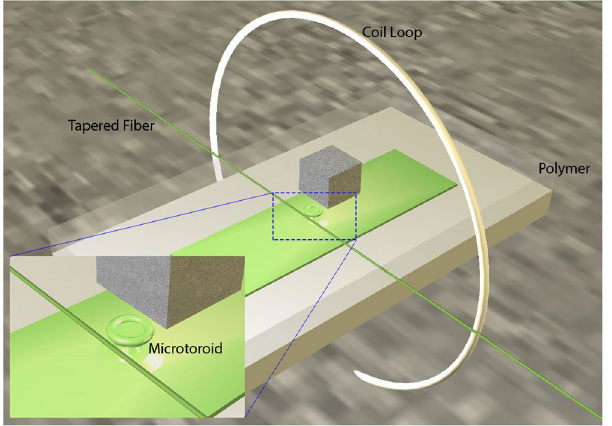
Figure 1. Illustration of the experimental setup of the microcavity magnetometer. The chip (green) with microtoroids and a tapered fiber (green) are encapsulated under polymer. The micro-magnet (cube) is glued above the microtoroid. Inset shows a magnified view of the microtoroid and the tapered